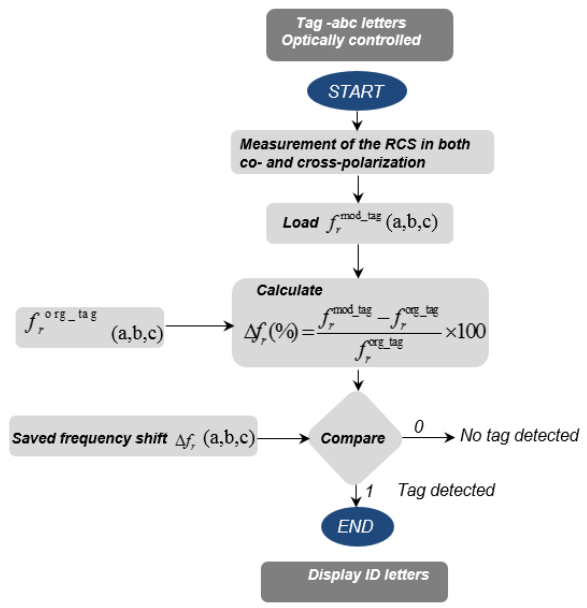
Figure 20. Algorithmic flow chart of the proposed method for robust detection .